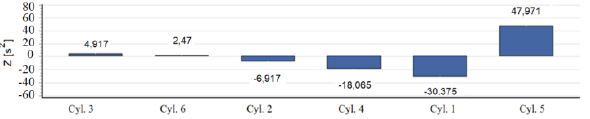
Fig. 11. Z measure as a function of time for individual engine cylinders for a damaged engine (disabling fuel supplying cylinder No.